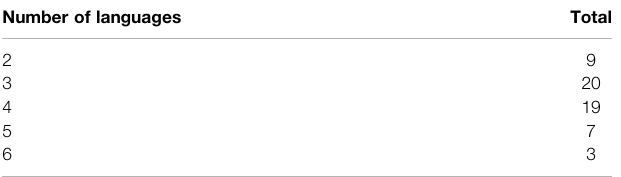
TABLE 2 | Number of participants per number of